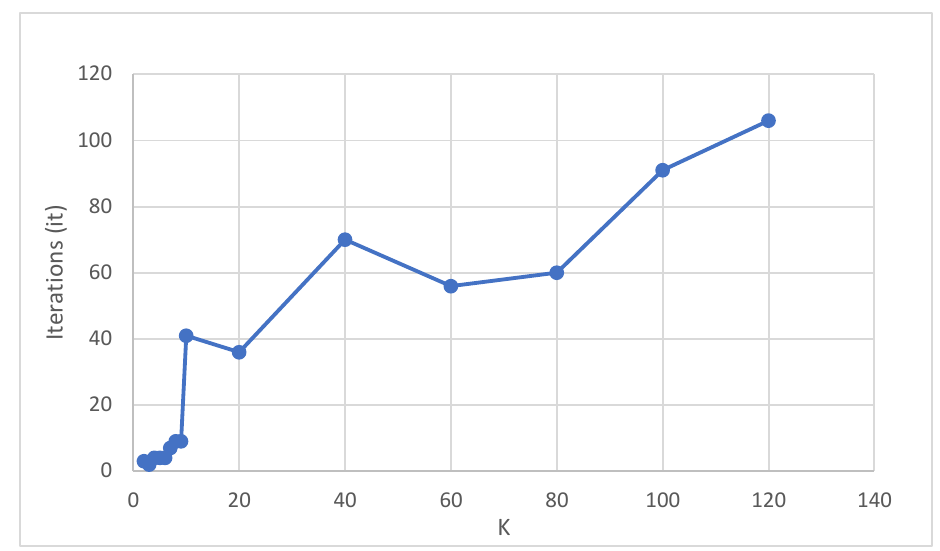
Figure 9. The “Elbow” curve, i.e., the 𝑆𝑆𝐷 cost vs. 𝐾 .